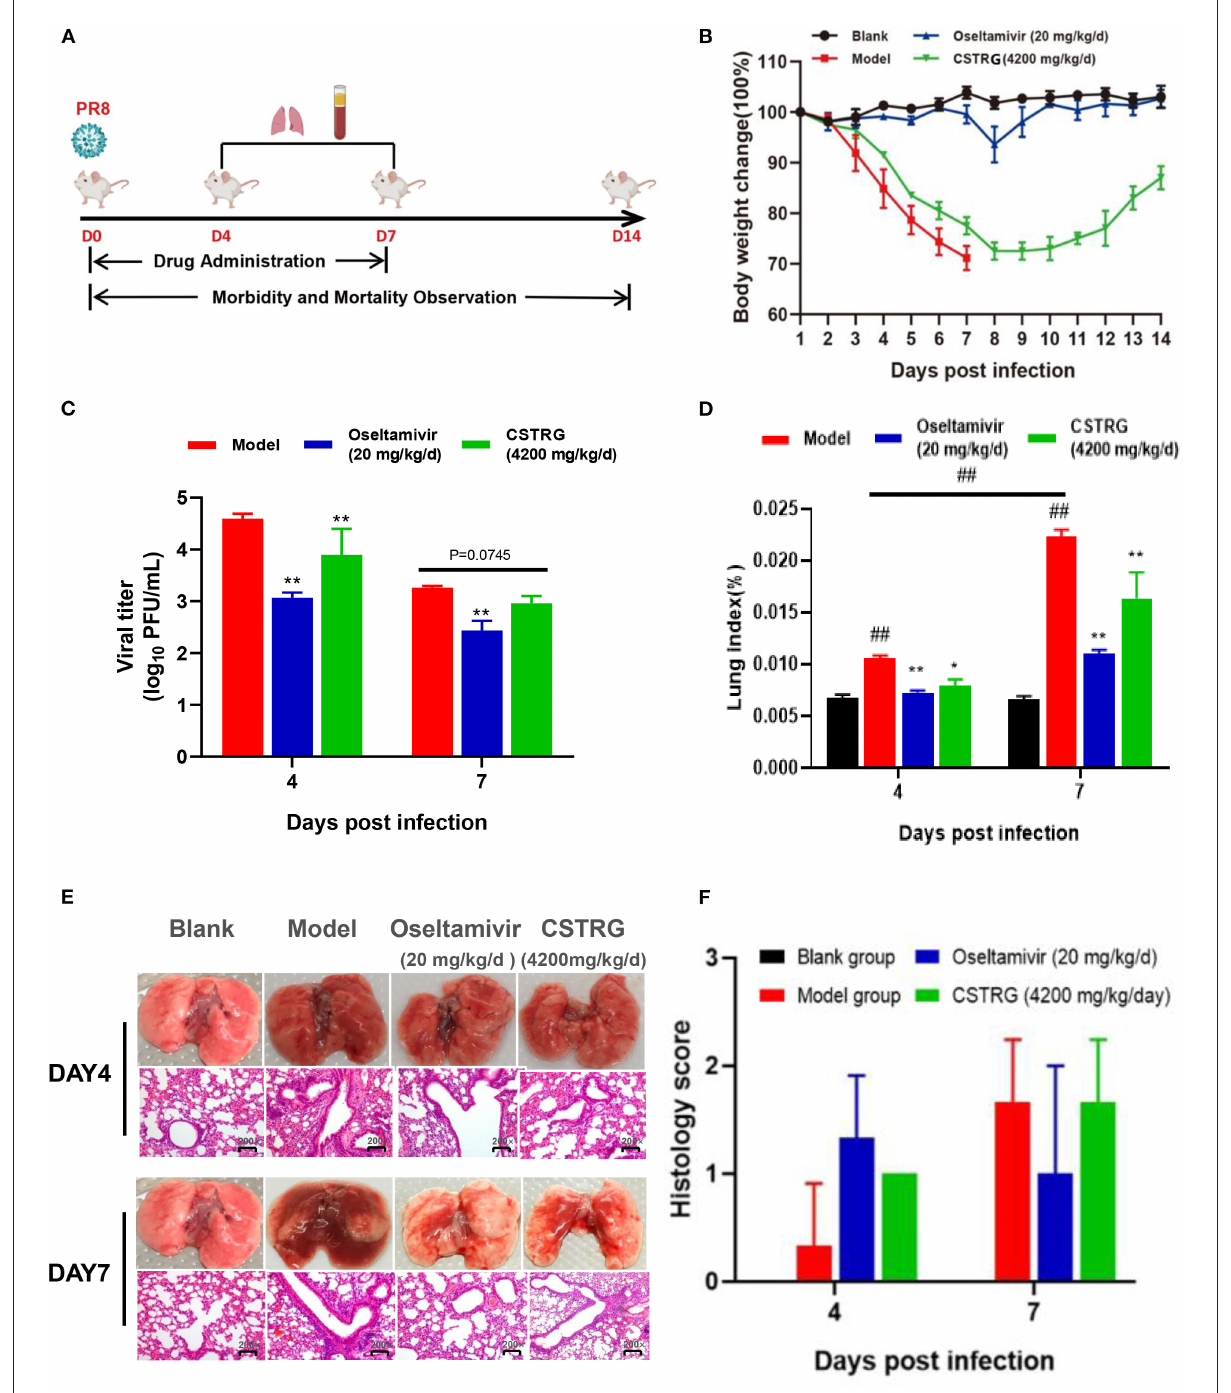
FIGURE2 CSTRG shows anti-viral activity and alleviates lung injury caused by IAV infection in mice. (A) Female BALB/c mice were infected with 6 MLD 50 of A/PR/8/34 (H1N1) virus and then were orally administered with CSTRG (4,200 mg/kg/d), Oseltamivir (20 mg/kg/d) for 7 successive days. Samples were collected on the 4th and 7th days post-infection (three mice/group/day). The clinical signs and weight change of infected mice were recorded for 14 successive days (six mice/group/day). (B) The body weight changes. (C) The influenza virus titers in mice lung tissues at the 4th and 7th days post-infection. (D) Lung index was recorded. (E) Sections of the lung tissues were visualized using hematoxylin and eosin (H&E) staining (Magnification: 200 × ). (F) Pathological score of lung tissue in mice. The data are presented as the means ± SD of 3 or 6 mice per group; compared with blank group, # p < 0.05; ## p < 0.01; compared with model group, * p < 0.05; ** p <